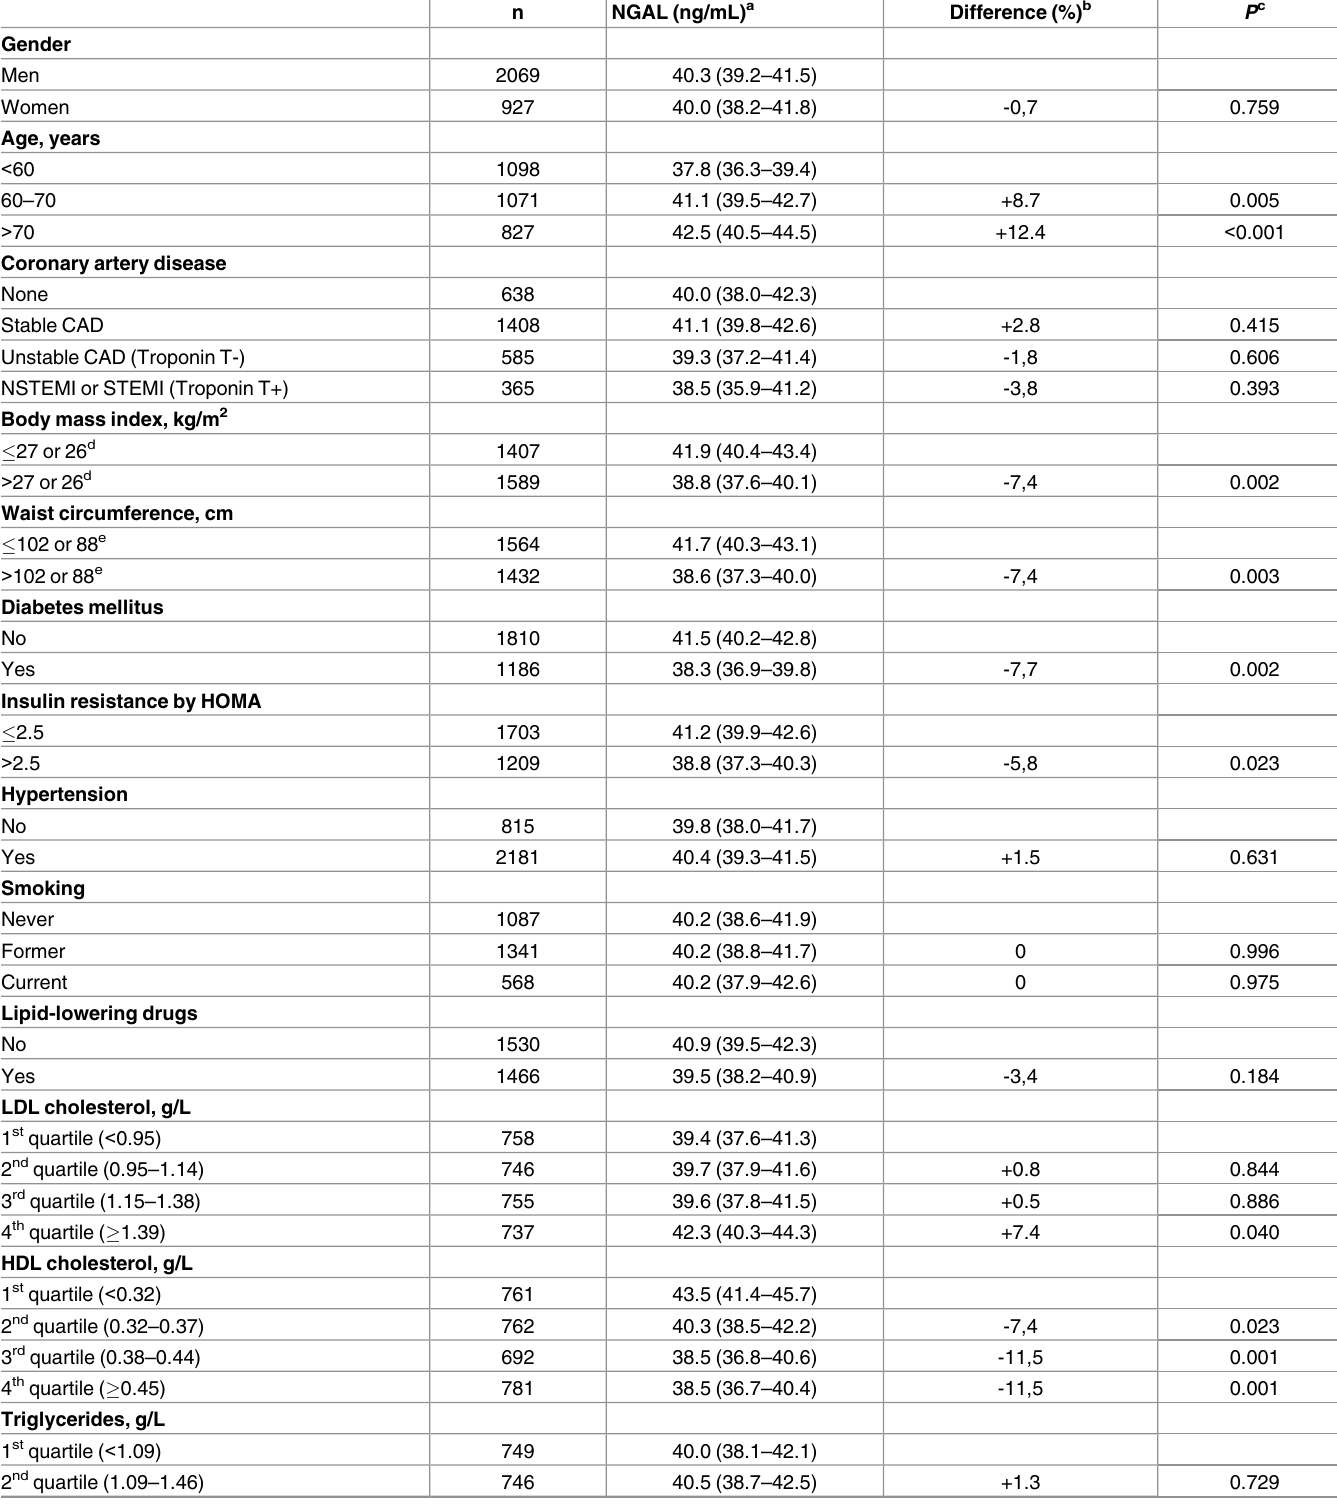
Table 1. Association of NGAL with cardiovascular risk factors and coronary